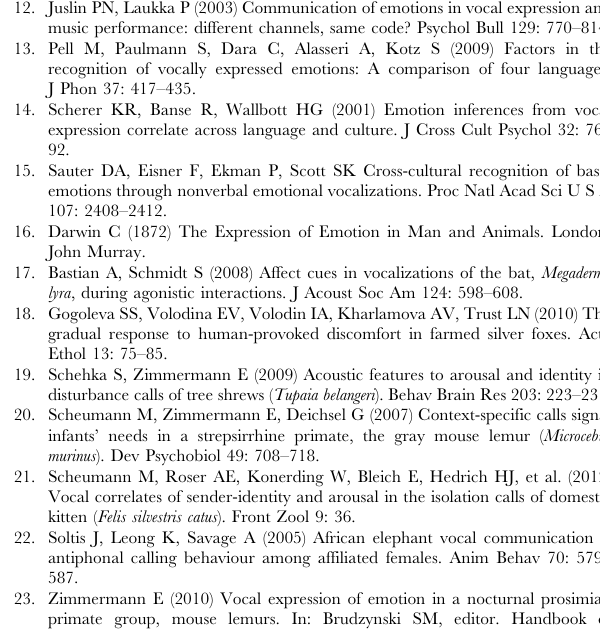
Table S1 Response categories related to the question ‘‘What kind of a sound was